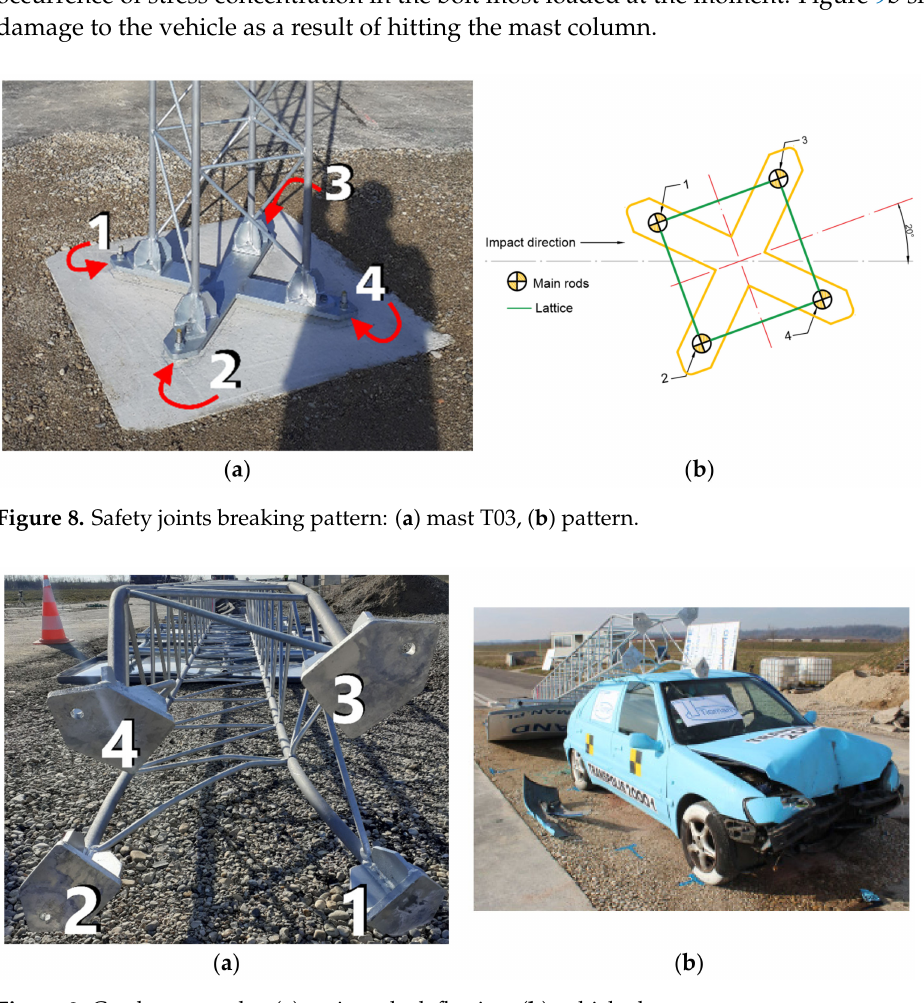
Figure 9. Crash test results: ( a ) main rods deflection, ( b ) vehicle